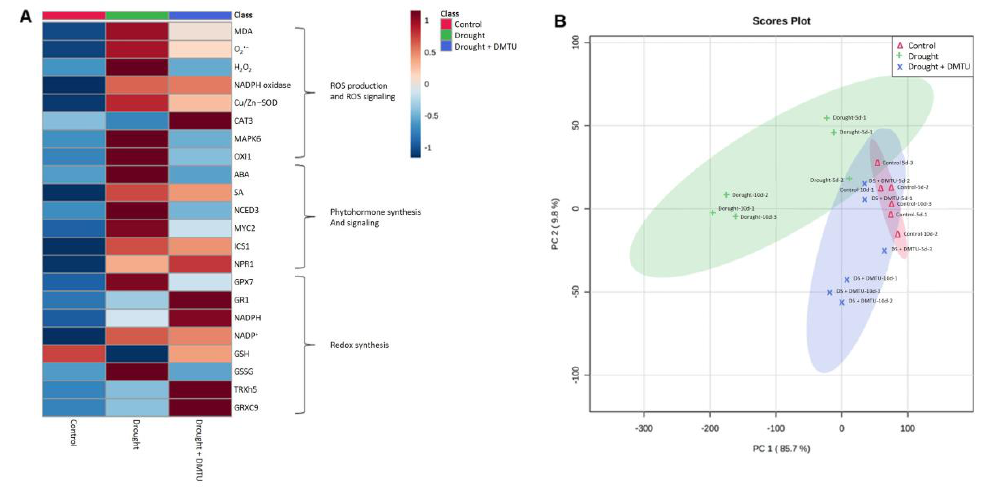
Figure 6. The heatmap analysis ( A ) and the principal component analysis (PCA) score plots ( B ) in the changes of the identified metabolites or gene expression levels in the reactive oxygen species (ROS) system-related, hormone, and redox signaling-related metabolism in the leaves of Brassica napus under control, drought, or drought with dimethylthiourea (Drought + DMTU) treatments for 10 days. ( A ) red indicates a positive effect, whereas blue indicates a negative effect. ( B ) pink, green, and purple colors indicate control, drought, and drought with DMTU treatments,